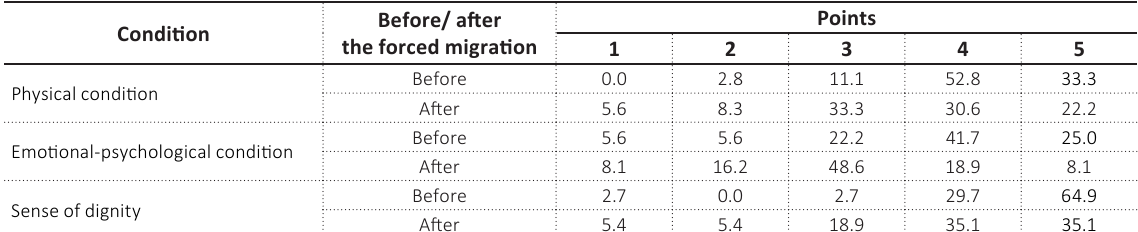
Table 2. Estimates of physical and emotional-psychological condition, sense of dignity and respect in the society of IDPs in Pidberiztsivska community, % of respondents